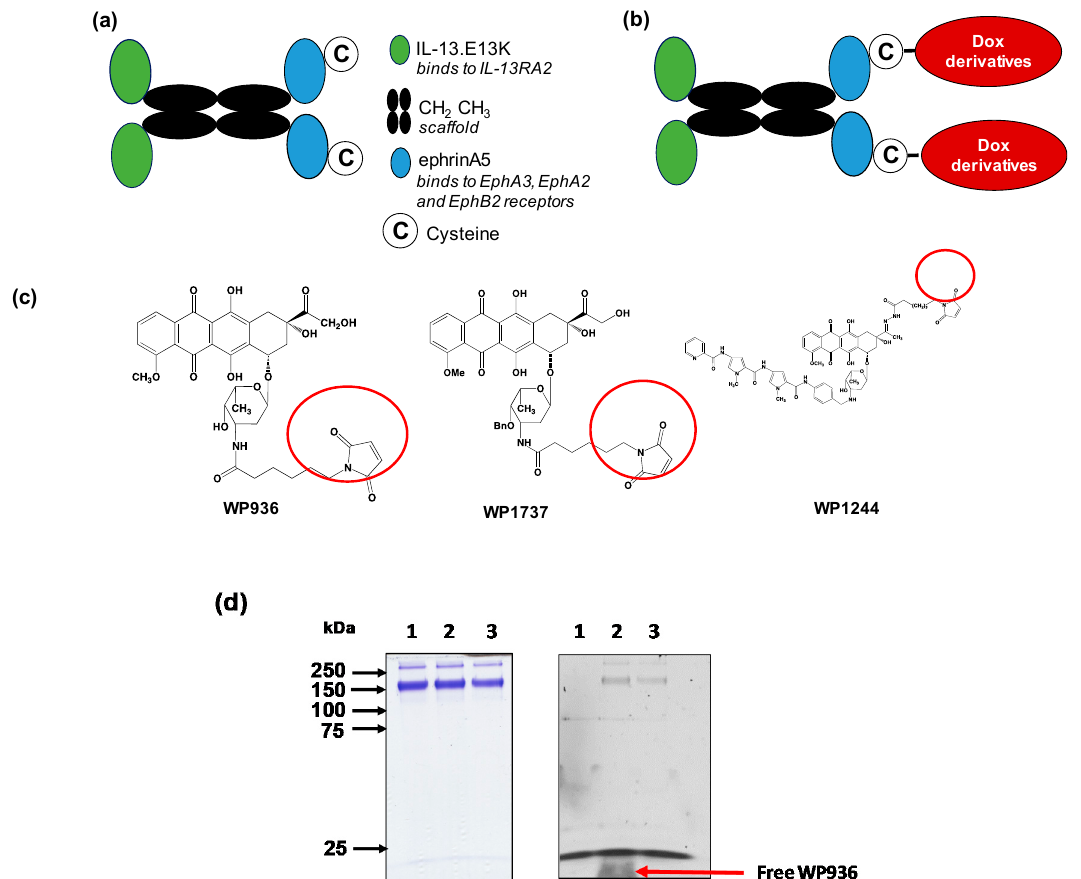
Figure 1. Dox derivatives conjugation to QUAD 3.0. ( a ) A schematic of the QUAD 3.0 protein showing the CH 2 CH 3 domains of the human IgG1 used as a scaffold. IL-13.E13K, a modified version of the IL-13 ligand, is present in the N-terminal of the molecule and ephrinA5 along with a cysteine present in the C-terminal end of the molecule; ( b ) A schematic of the conjugation of Dox derivatives to the QUAD 3.0 molecule; ( c ) The structure of the three Dox derivatives used in the study that are thiol reactive (circled) and form a stable thioether bond with the thiol present in the cysteine residue; ( d ) SDS-PAGE (left panel) and corresponding fluorescent image the same gel (right panel) of QUAD 3.0 (lane 1) and its QUAD 3.0-WP936 conjugate before (lane 2) and after the removal of excess unconjugated WP936 using a Zeba desalting column (lane 3). To detect the fluorescently labeled protein, the gel was scanned using an Amersham AI 600RGB digital scanner.